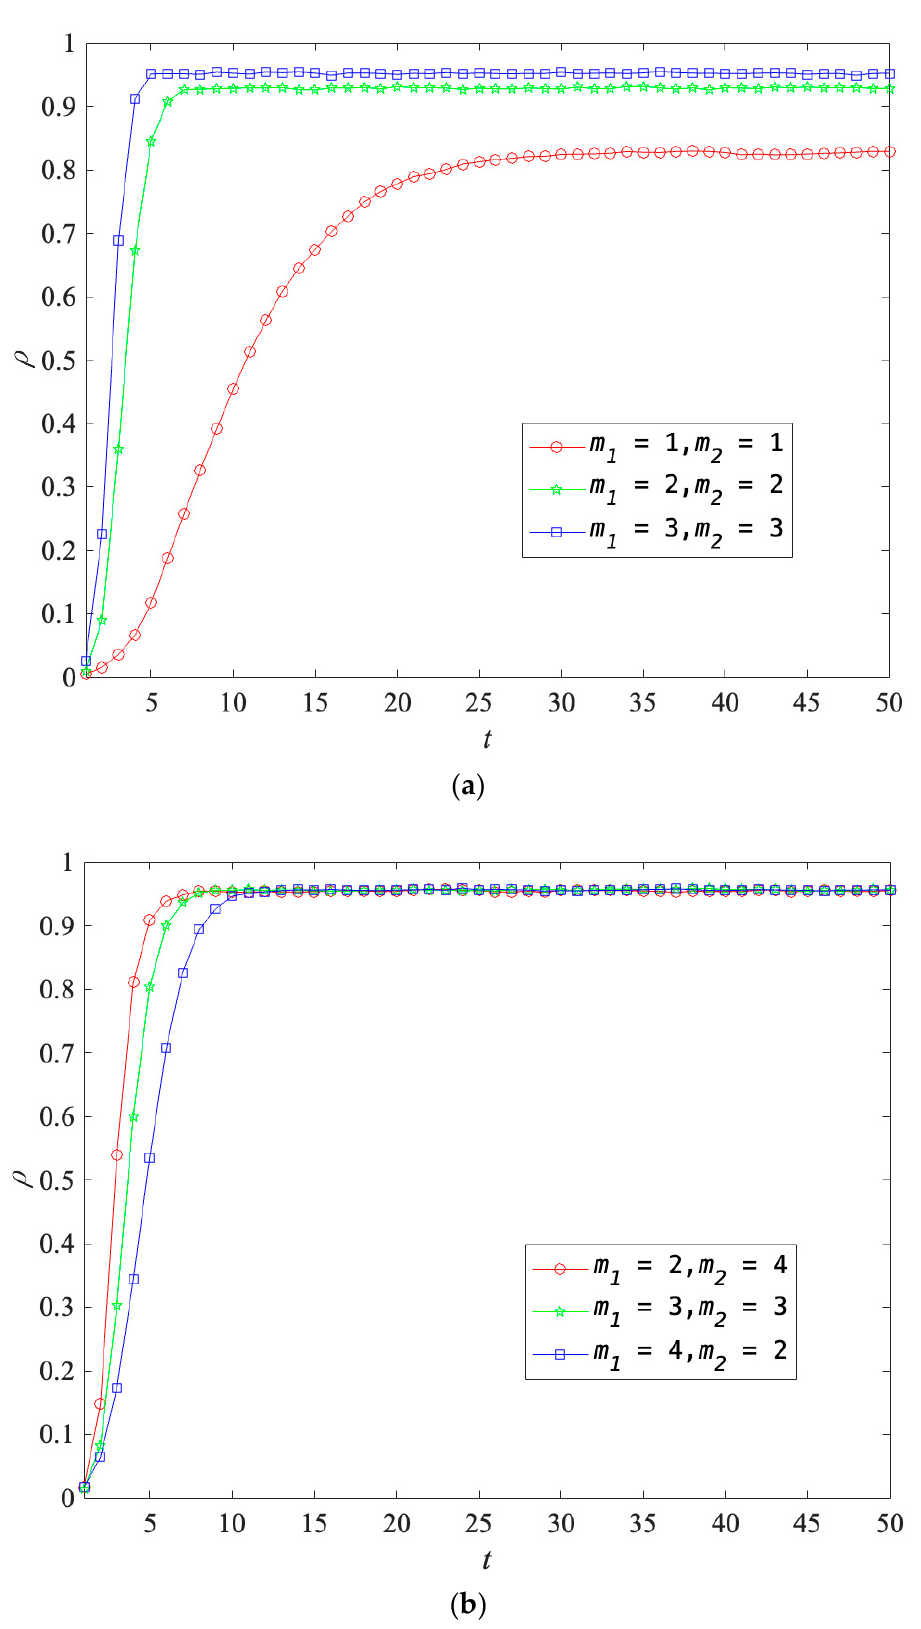
Figure 9. The simulated density of infected nodes ρ vs. time t for different values of m 1 + m 2 . ( a ) m 1 = m 2 , whereas the value of m 1 + m 2 varies; ( b ) m 1 (cid:54) = m 2 , but m 1 + m 2 has the same